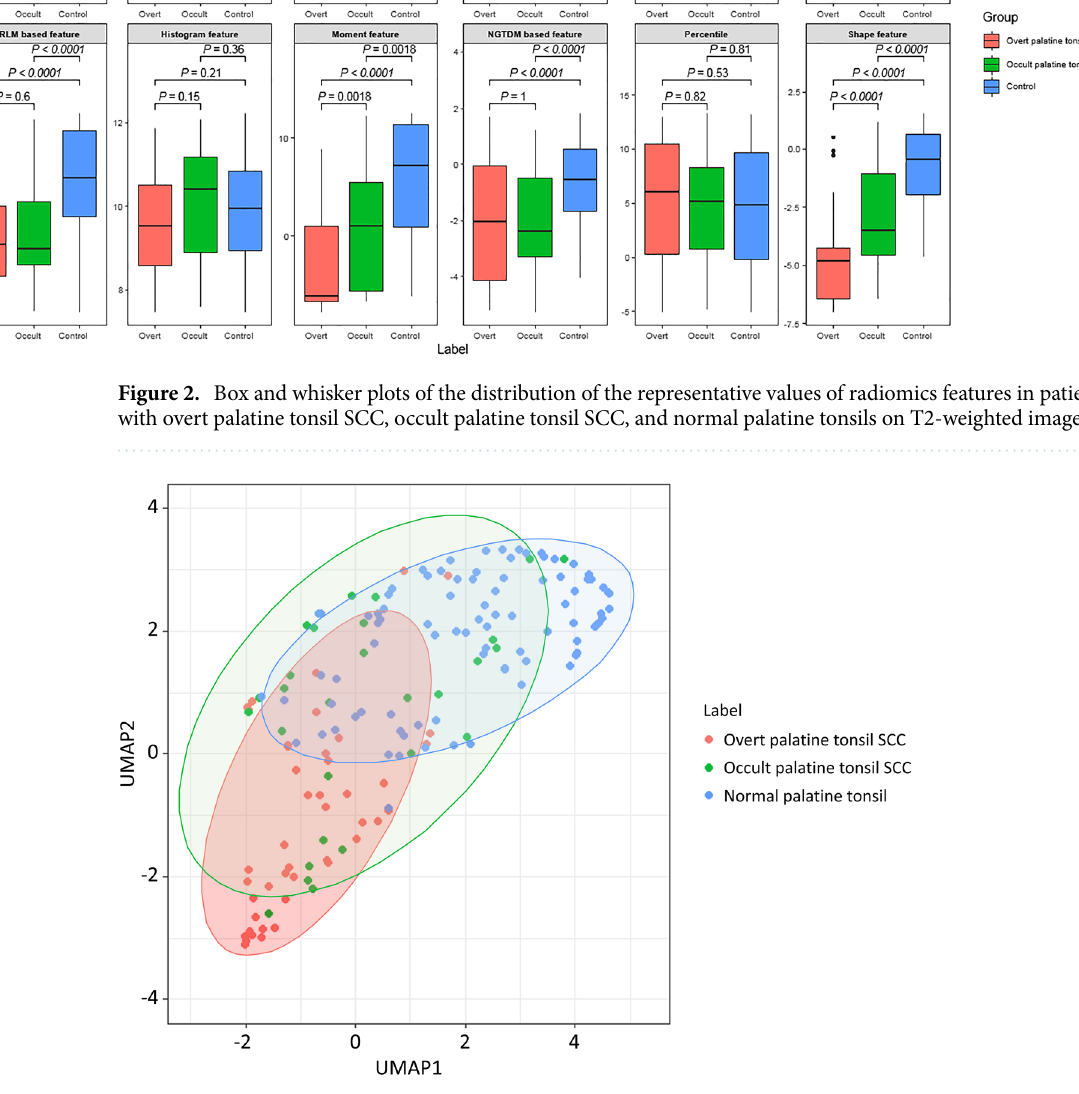
Figure 3. Dimensionality reduction of shape features through the Uniform Manifold Approximation and Projection algorithm 20 (https ://githu b.com/ropen scila bs/umapr ,